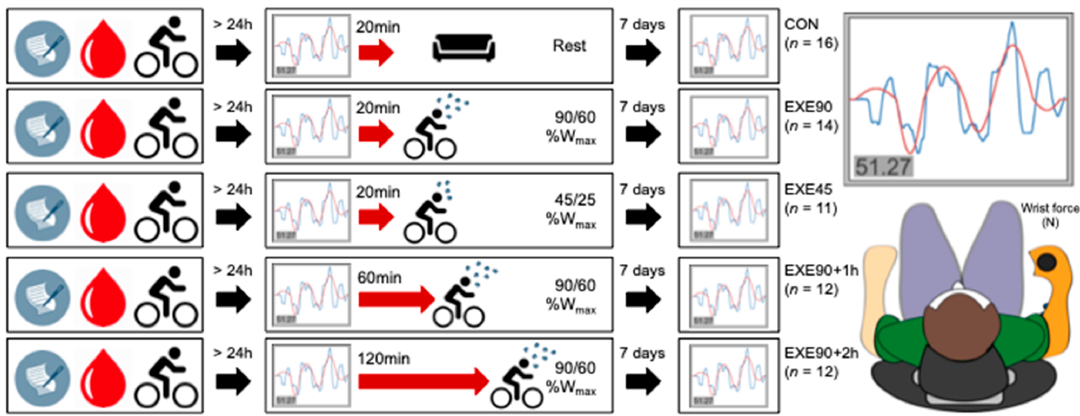
Figure 1. Experimental Design and Visuomotor Accuracy Task (VAT). ( Left ) A schematic